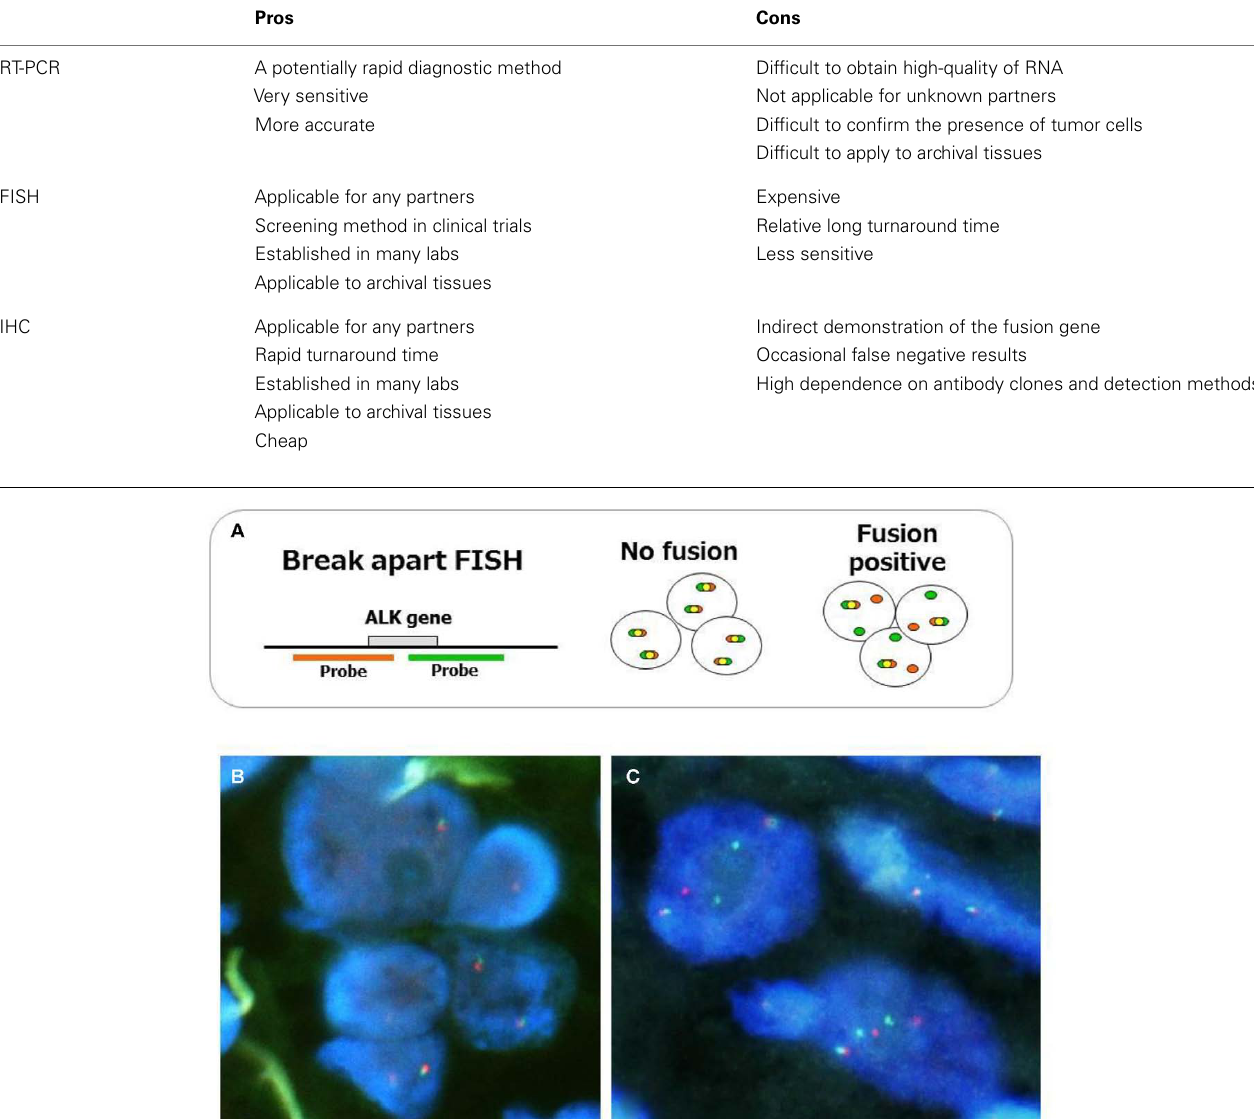
FIGURE 3 | Fluorescent in situ hybridization method forALK fusion detection. The probes, which are labeled with different fluorescences, are designed at telomeric and centromeric sides between break point (A) . Representative FISH images of ALK-negative (B) and positive tumors (C) are displayed.When ALK is translocated, the signals are changed from merged yellow to single red and green.The current criteria of the gene rearrangement and positive ALK FISH are as follows. Cells are considered rearrangement positive when: (i) At least one set of orange and green